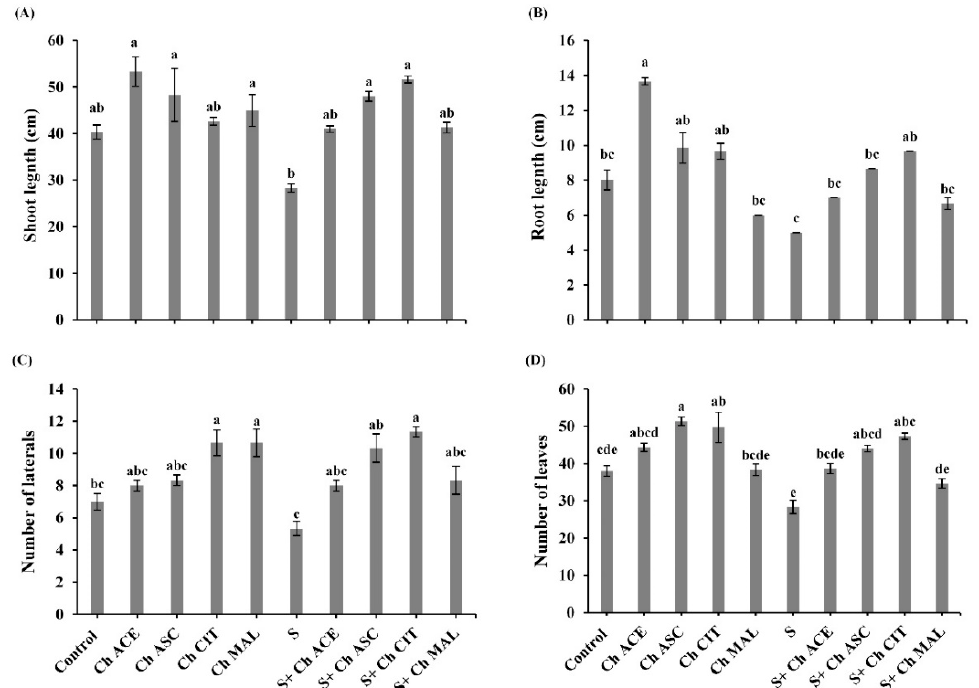
Figure 2. Effect of salinity (S) and foliar application of chitosan dissolved in different organic acids (Ch ACE, Ch ASC, Ch CIT and Ch MAL) and their interactions on ( A ) Shoot length, ( B ) Root length, ( C ) Number of laterals and ( D ) Number of leaves of tomato plants. Data are presented as means ± SE (n = 3). Data followed by different letters are significantly different following Tukey’s honestly significant difference (HSD) test at p ≤ 0.05.